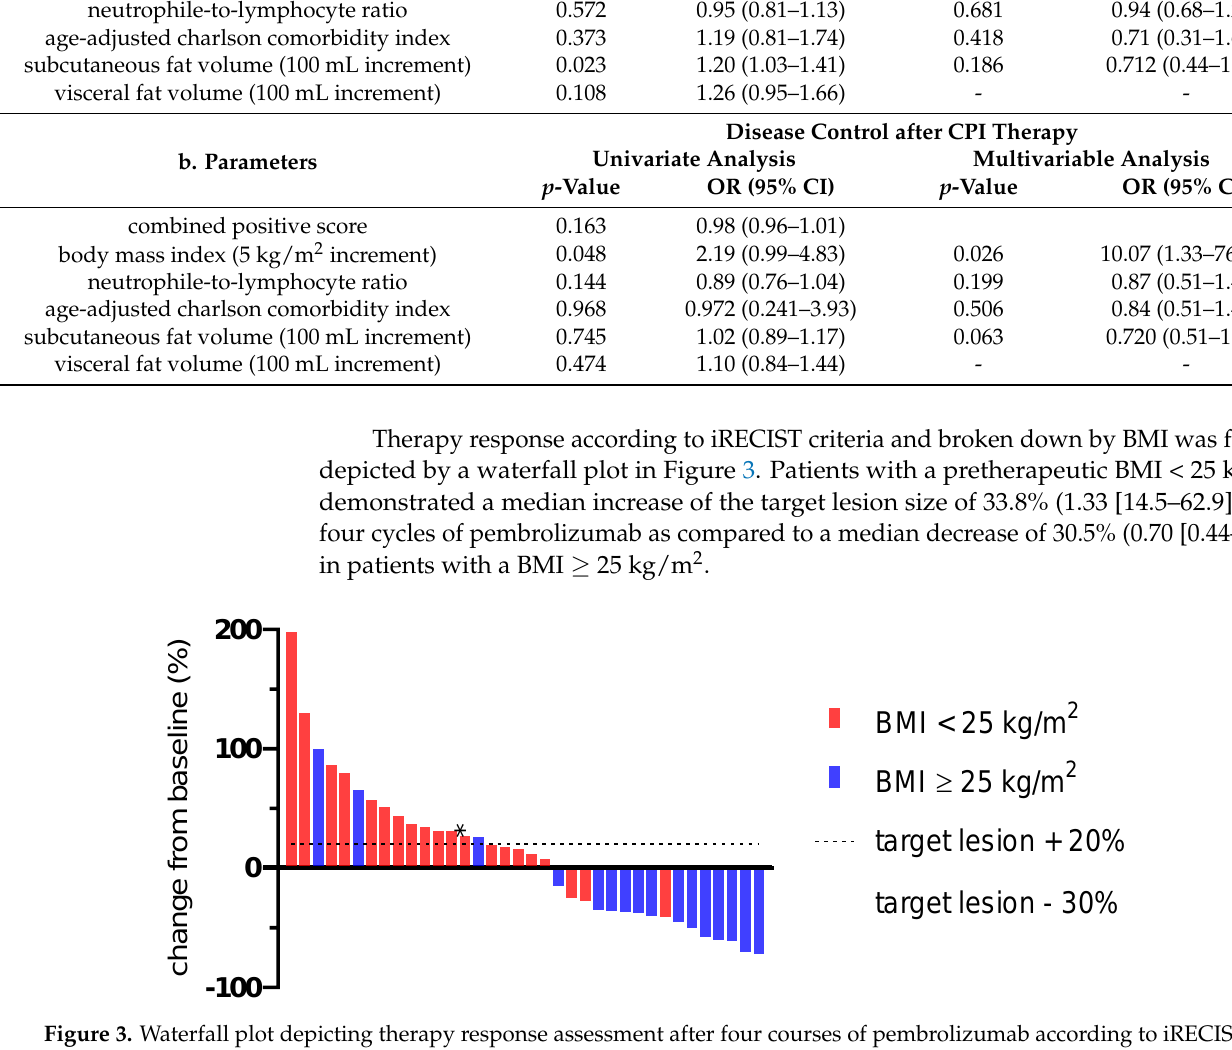
Figure 3. Waterfall plot depicting therapy response assessment after four courses of pembrolizumab according to iRECIST criteria, broken down by pretreatment body mass index. Dashed and dotted lines mark the respective progressive disease and partial response thresholds. The bar marked by an asterisk (*) represents a case which was defined as unconfirmed PD after initial restaging. Progression was not confirmed after eight weeks and was therefore labeled as “stable disease” for further analyses. Table 2. Univariate and multivariate analysis to assess parameters predictive for overall response (2a) and disease control (2b) at the timepoint of pembrolizumab therapy initiation.